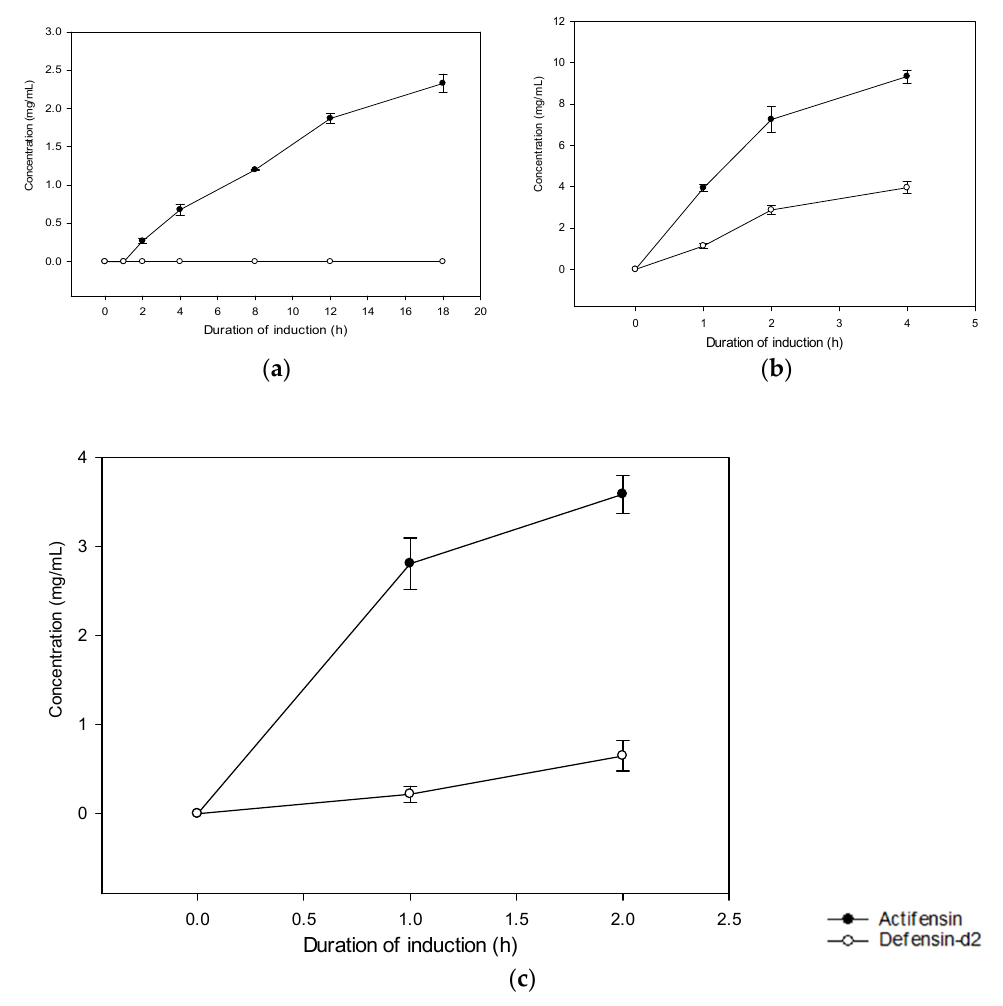
Figure 4. Time curves for the expressions of total soluble recombinant fusion proteins per induction condition: ( a ) expression at 15 °C for 18 h; ( b ) expression at 30 °C for 4 h; ( c ) expression at 37 °C for 2 h. Graph shows means and standard error means (error bars) of triplicate data per induction time.